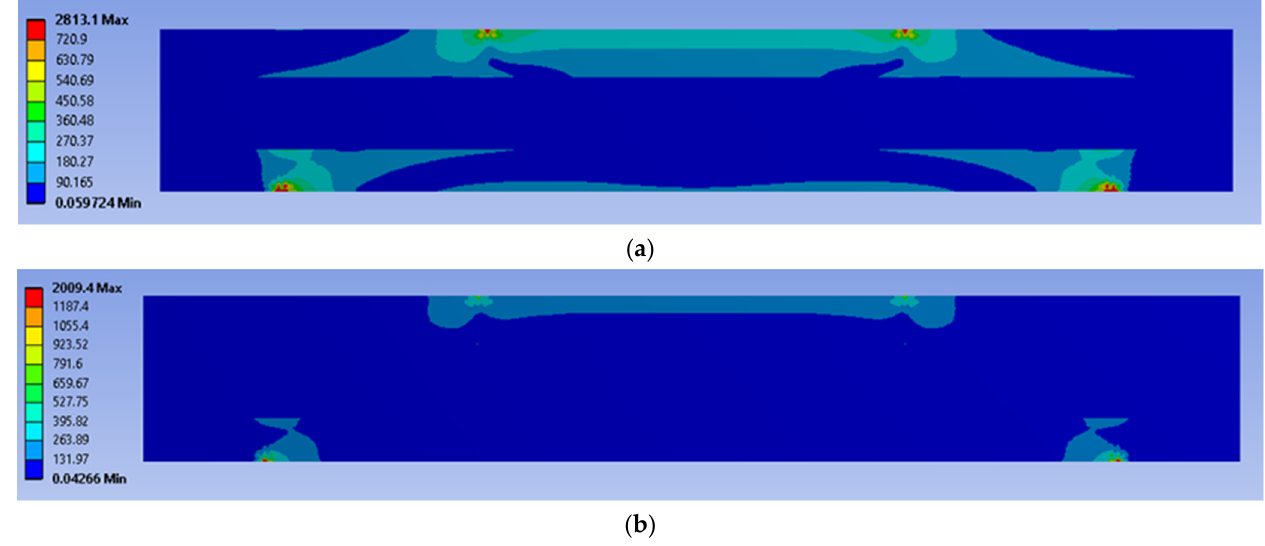
Figure 9. The stress distribution on a simulated panel under cyclic loading conditions (units in MPa): ( a ) 70%, ( b ) 50%.